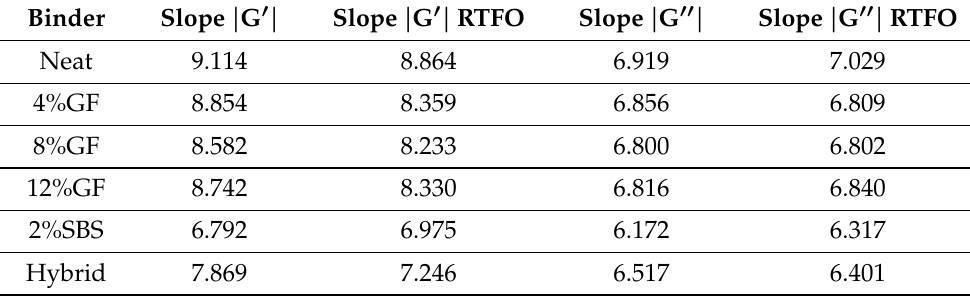
Table 6. Geopolymer’s effect on the regression slope of storage and loss modulus.